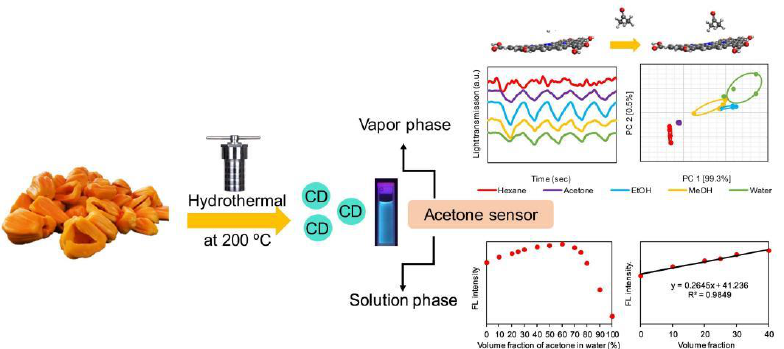
Figure 6. Schematic illustration of the synthesis and application of CDs from jackfruit. Adapted with permission from Thongsai et al., 2019, copyright 2019. Reproduced with permission from Elsevier